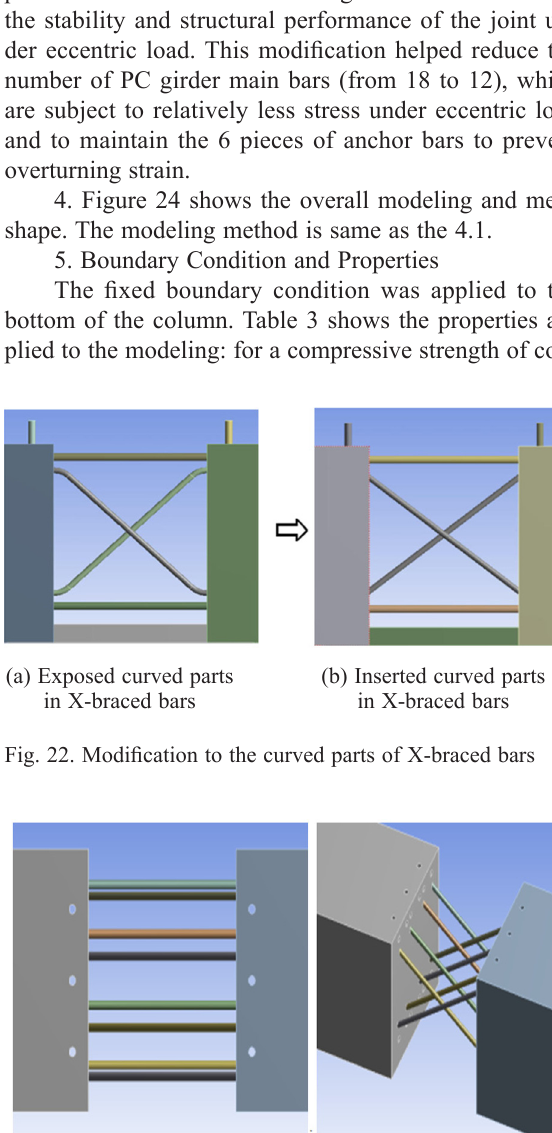
Fig. 23. Increasing X-braced bars (4→8)